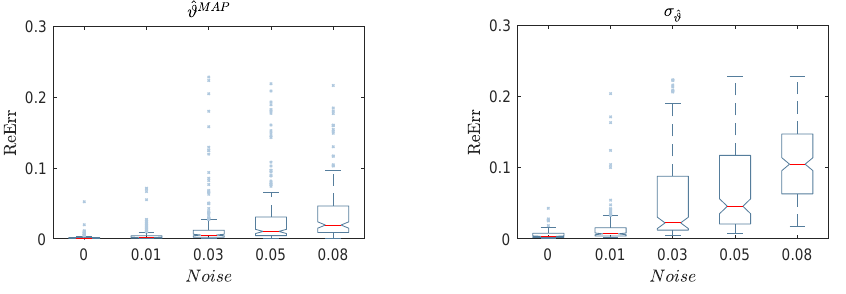
Figure 8. Box-plot of the reconstructed error (ReErr) of the identified damage location ˆ ϑ , classified based on noise level: the MAP values ˆ ϑ MAP ( left ); and the standard deviation σ ˆ